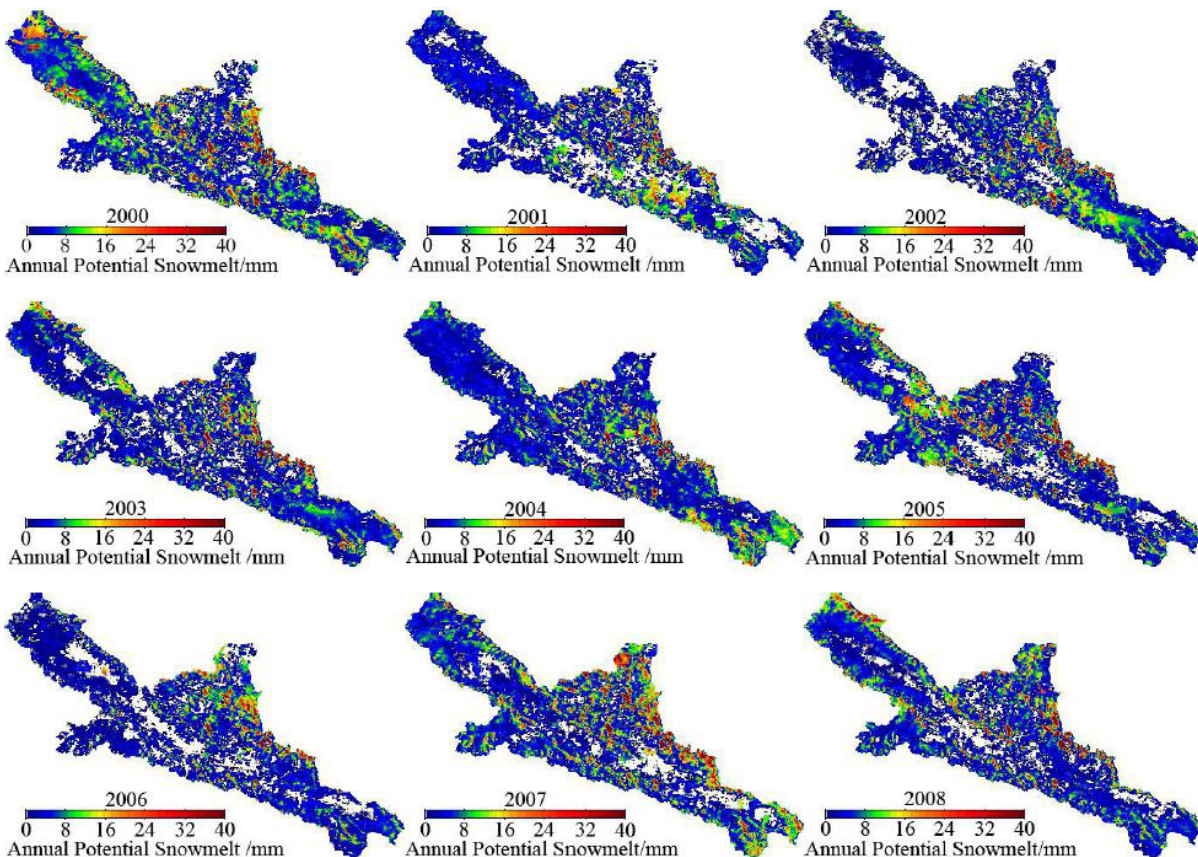
Fig. 12. Annual potential snowmelt distribution in the upper basin of Heihe River from 2000 to 2008.